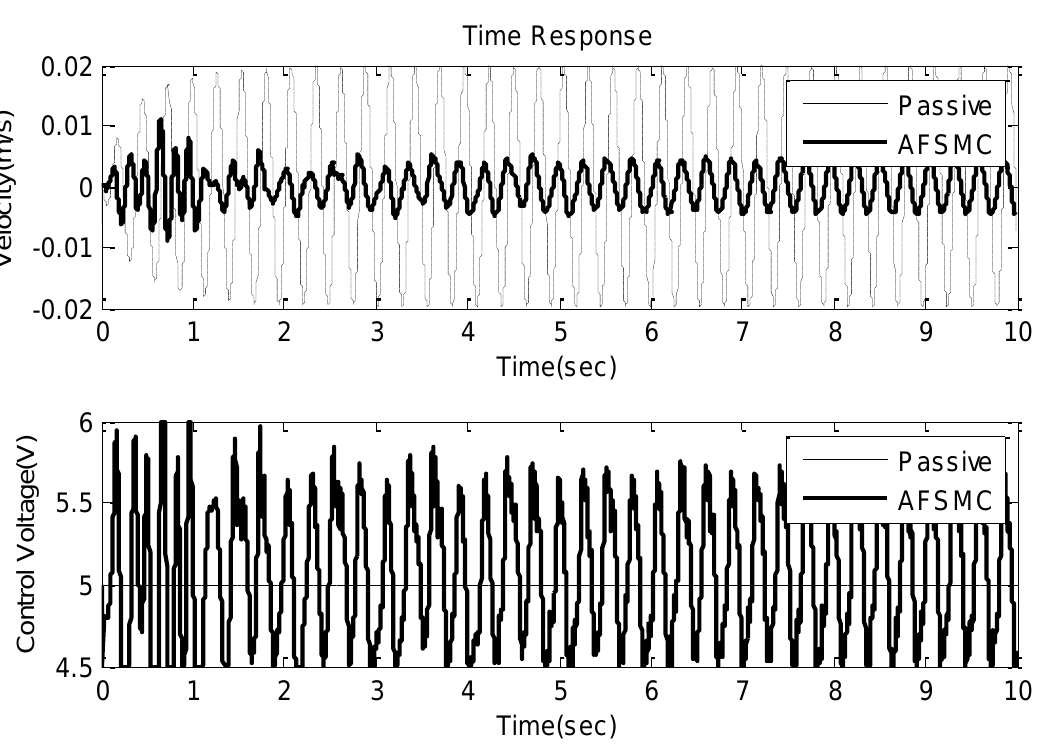
Figure 5. Time domain velocity response (upper) and control voltage (lower) of the passive and AFSMC-active isolator under sinusoidal